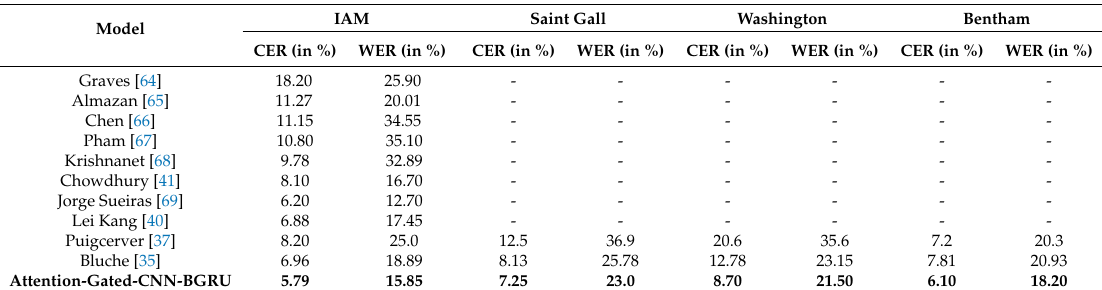
Table 5. Comparison of results on public datasets.